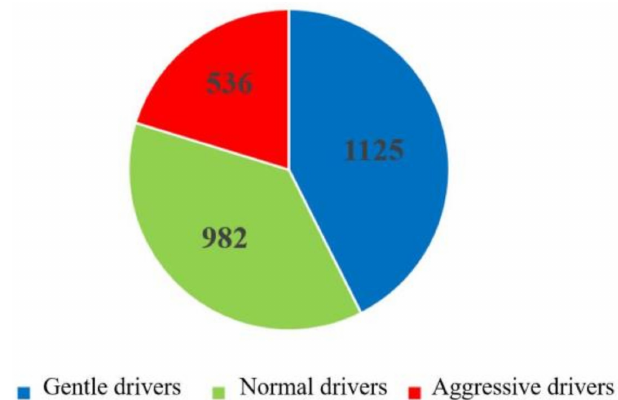
Figure 7. Distribution of different driver